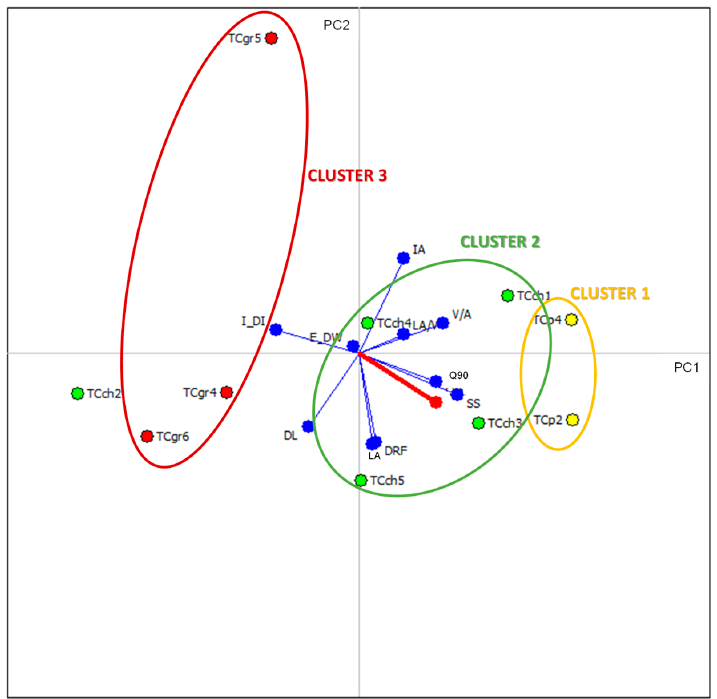
Figure 10. Geometrical Analysis for Interactive Aid (GAIA) analysis for assessing the influence of each factor (79% explained variance with the first two PCs).